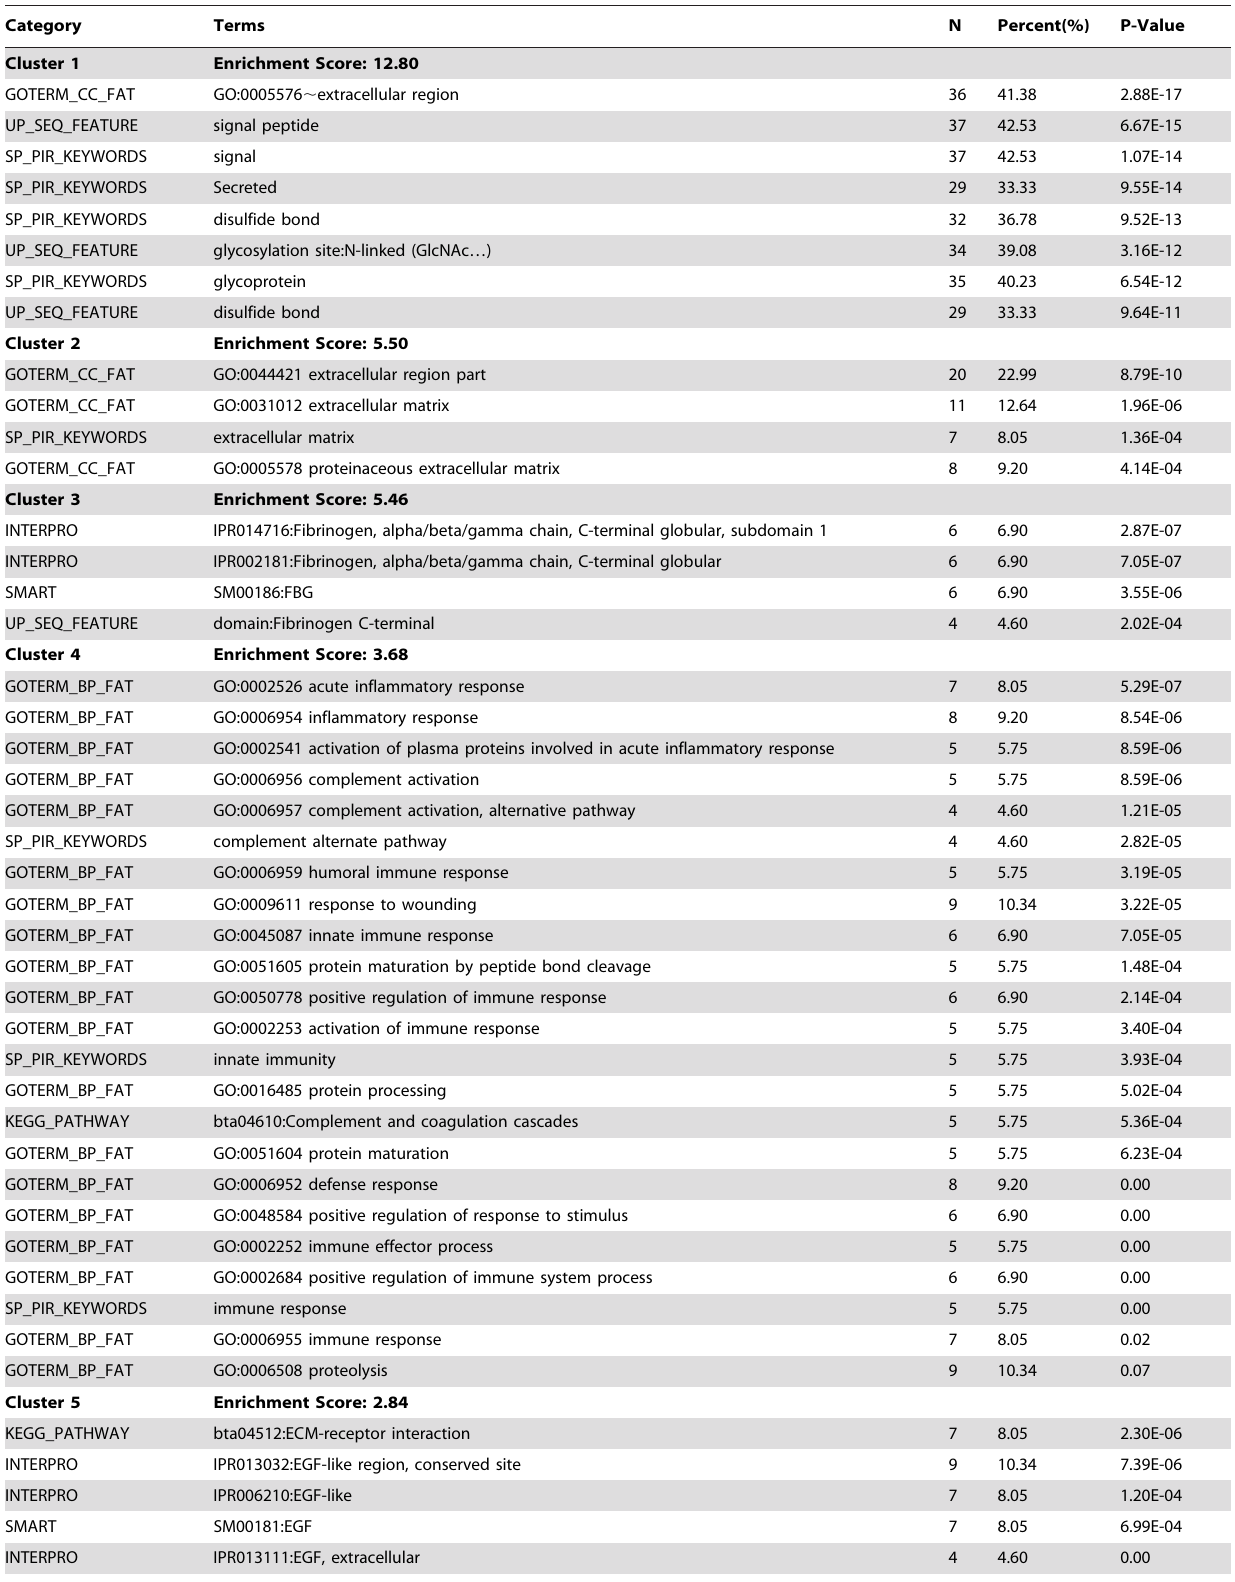
Table 7. Functional annotation clustering of genes downregulated in stage I and then upregulated in stage II of lactogenesis.